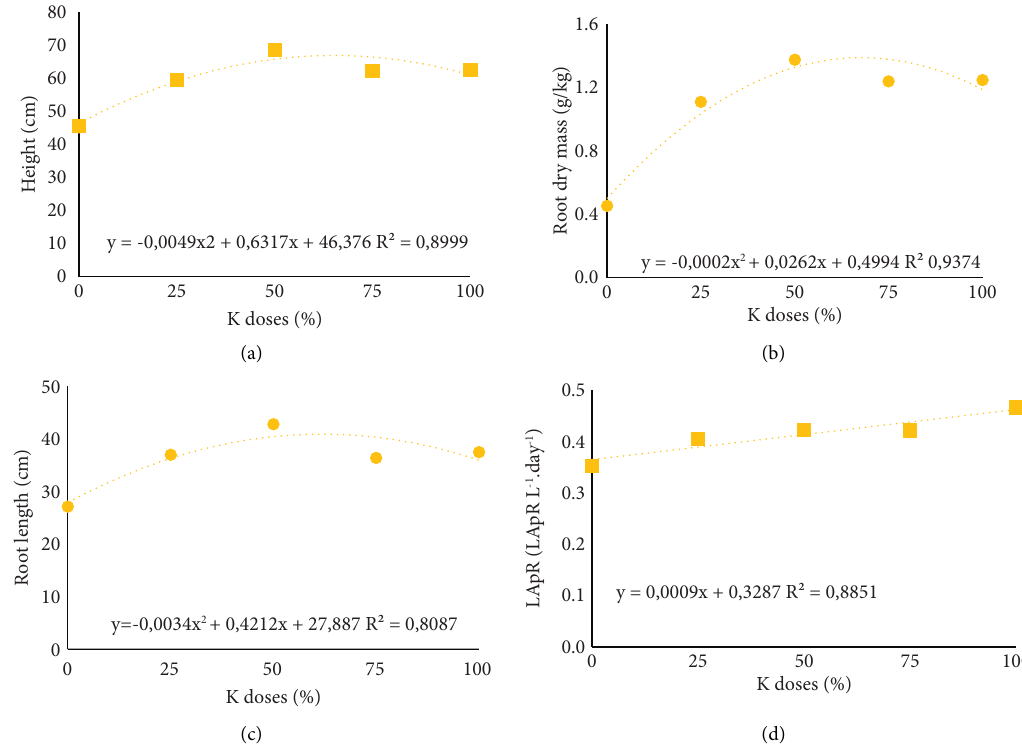
Figure 6: Isolated efect of reduced potassium doses on height (a), root dry mass (b), root length (c), and leaf appearance rate (d) of Urochloa brizantha cv. Marandu. Table 1: Efect of inoculation with Bacillus subtilis (UFRA-92) and Trichoderma asperellum +UFRA-92 (MIX), associated with 75% N, 50% P 2 O 5 , and 50% K 2 O, on biometric parameters of Urochloa brizantha cv. Marandu.